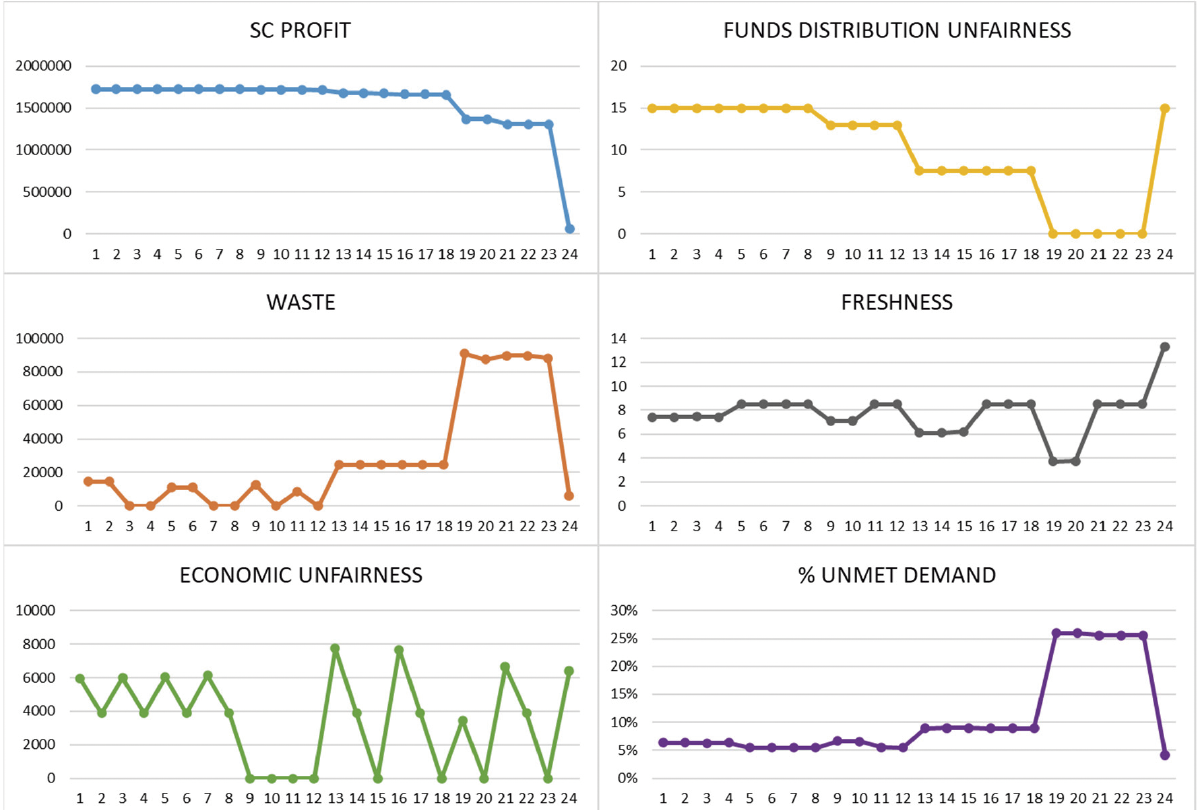
Figure 3. Non-dominated solutions for the multi-objective